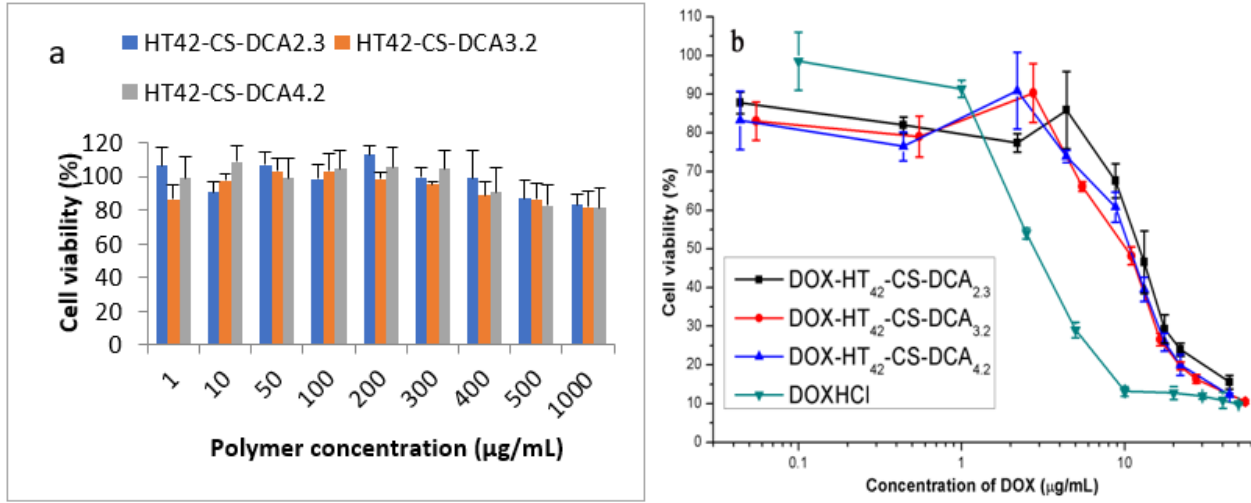
Figure 6. Cytoactivity test of MCF-7 cells cultured with HT 42 -CS-DCA nanoparticles for 48 h ( a ); the results represent the average value ± SD ( n = 6). Cytoactivity test of MCF-7 cells cultured with DOX − HT 42 -CS-DCA nanoparticles and DOX • HCl for 48 h ( b ); the results represent the average value ± SD ( n = 6).